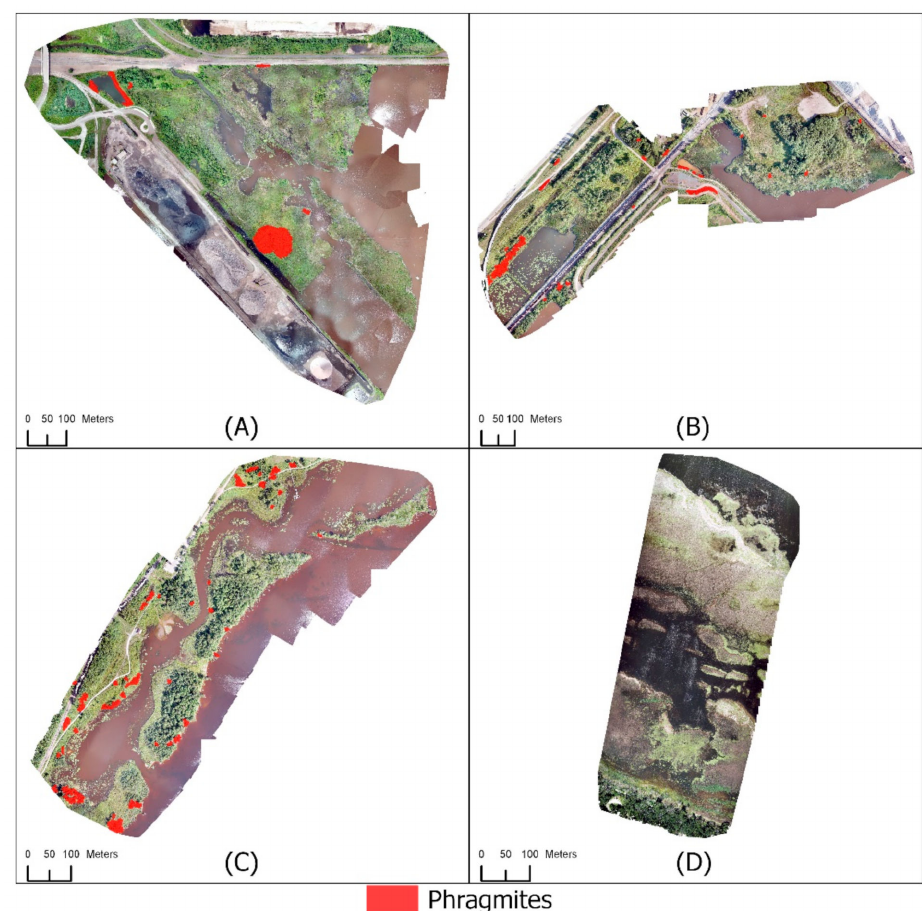
Figure 8. Mapping Phragmites using RGB UAS imagery, UAS-derived CHM, and RADARSAT-2 HH